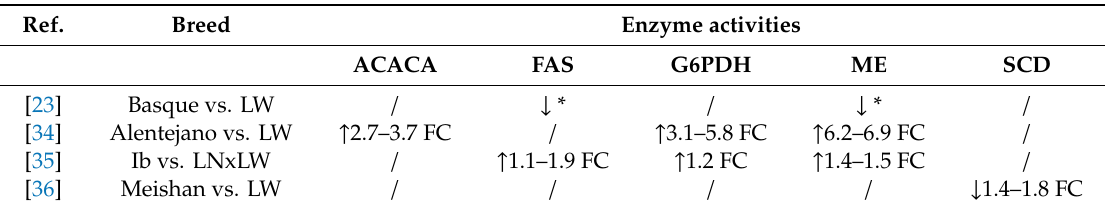
Table 2. Lipogenic enzyme activities in subcutaneous adipose tissue in local compared to modern pig breeds.